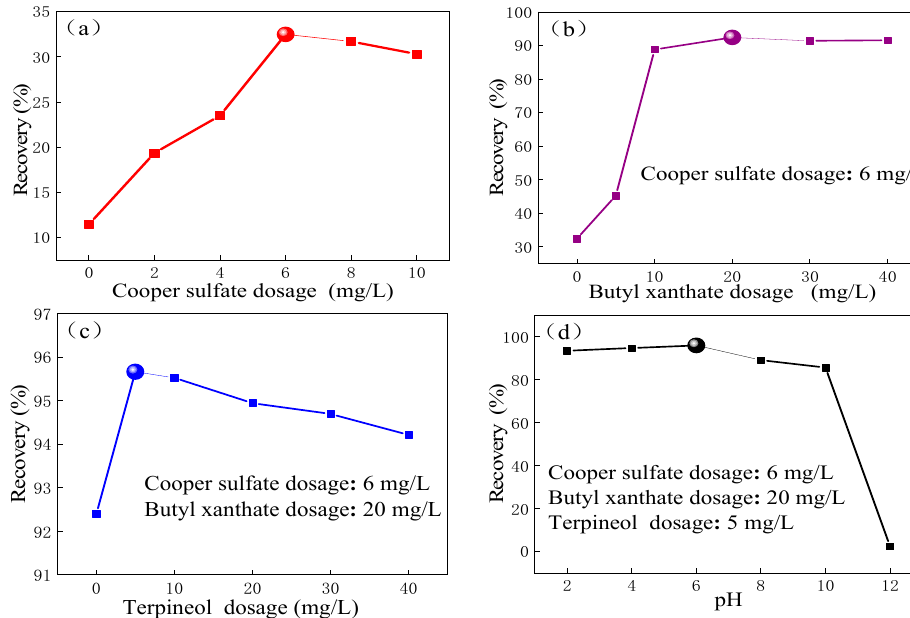
Figure 4. Effect of pH and flotation reagents dosage on pyrite flotation. ( a ) Copper sulfate firstly; ( b ) butyl xanthate secondly; ( c ) terpineol thirdly; ( d ) pH value lastly.